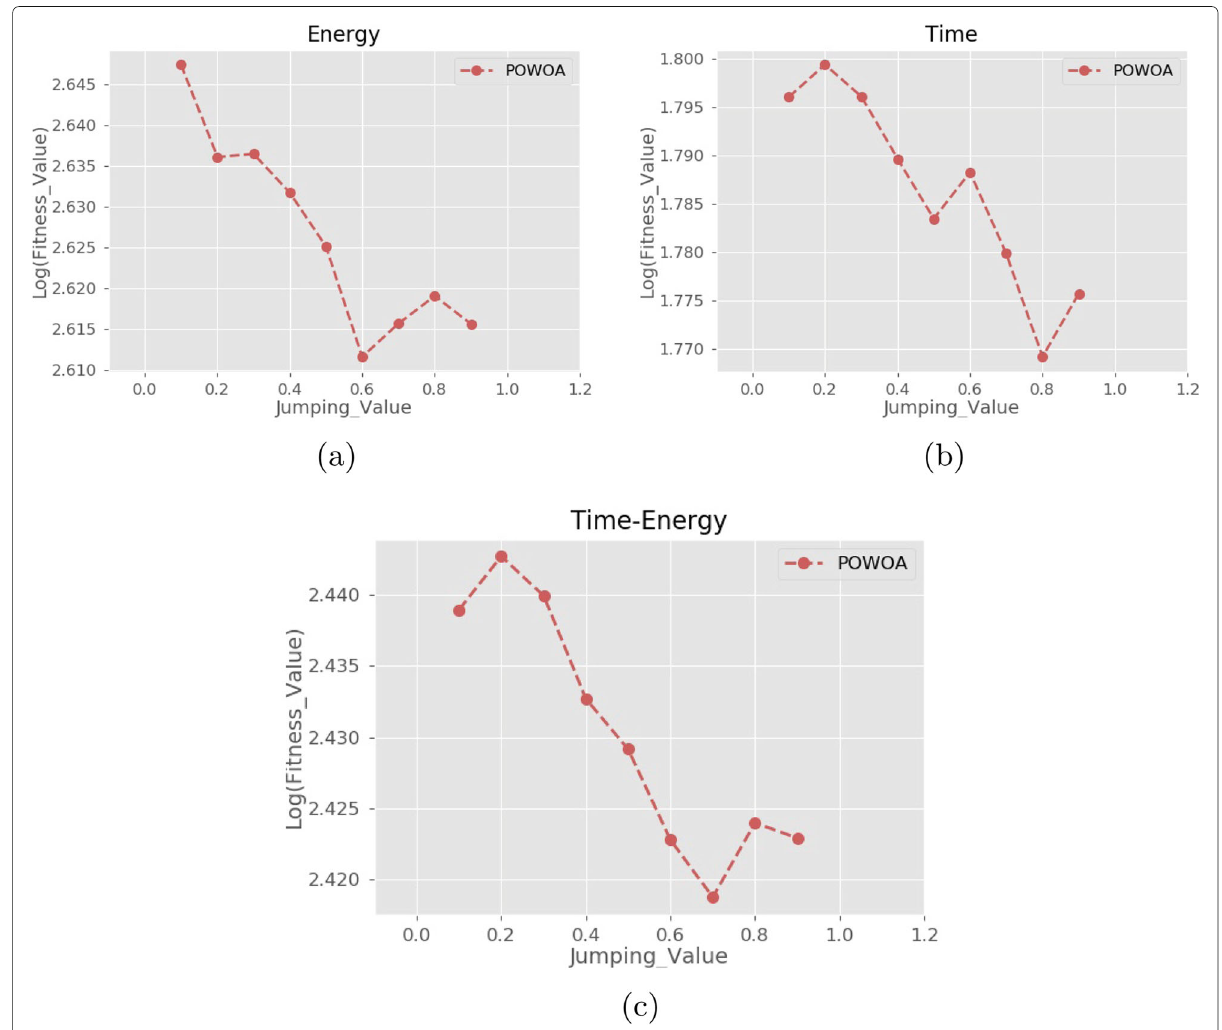
Fig. 10 Effect of jumping rate on the behavior of POWOA